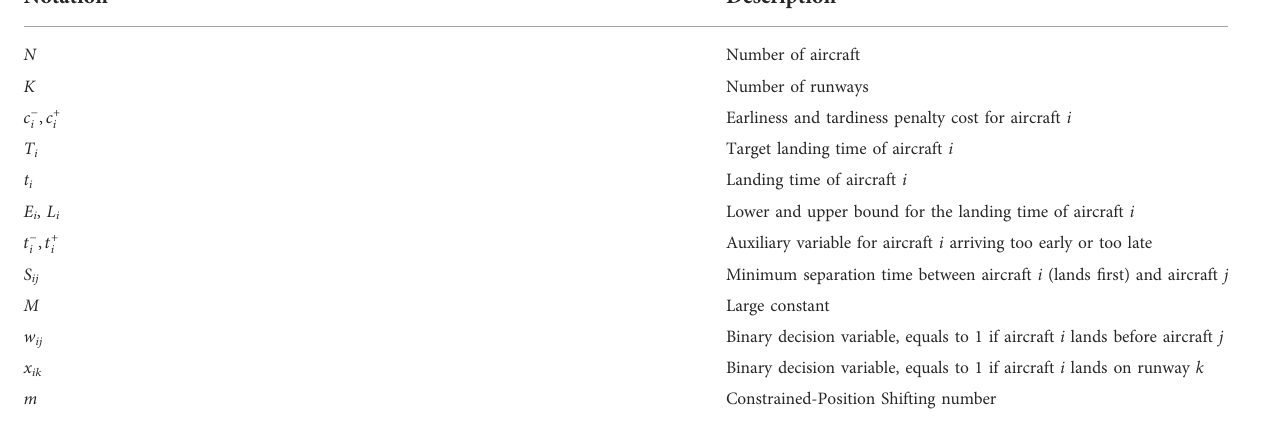
TABLE 1 Quantities and variables introduced in this paper.